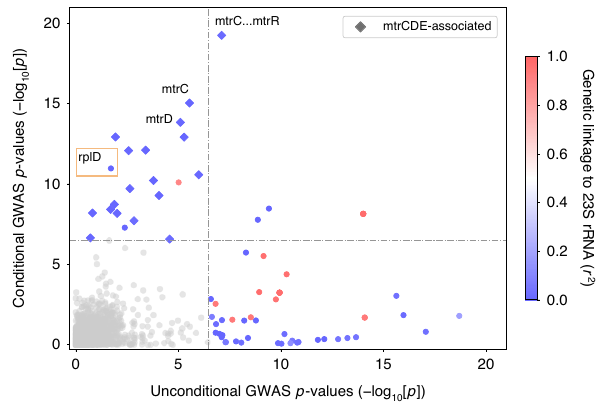
Fig. 1 GWAS conditional on 23S rRNA mutations and dataset demonstrates decreased confounding and increased power. Each variant is plotted using negative log 10 -transformed p -values, calculated using likelihood-ratio tests, for the association with azithromycin MICs in unconditional and conditional GWASes. Genetic linkage measured by r 2 to 23S rRNA mutations A2059G and C2611T is colored for signi fi cant variants as indicated on the right, ranging from 0 (blue) to 0.5 (white) to 1 (red). Variants associated with previously experimentally veri fi ed resistance mechanisms in the mtrR and mtrCDE promoters and coding regions are denoted using diamonds. Bonferroni thresholds, calculated using the number of unique patterns, for both GWASes are depicted using a gray dashed line at 3.38 × 10 − 7 . Plot axes are limited to highlight variants associated with lower-level resistance; as a result, the highly signi fi cant 23S rRNA substitutions and mtrC indel mutations 7 are not